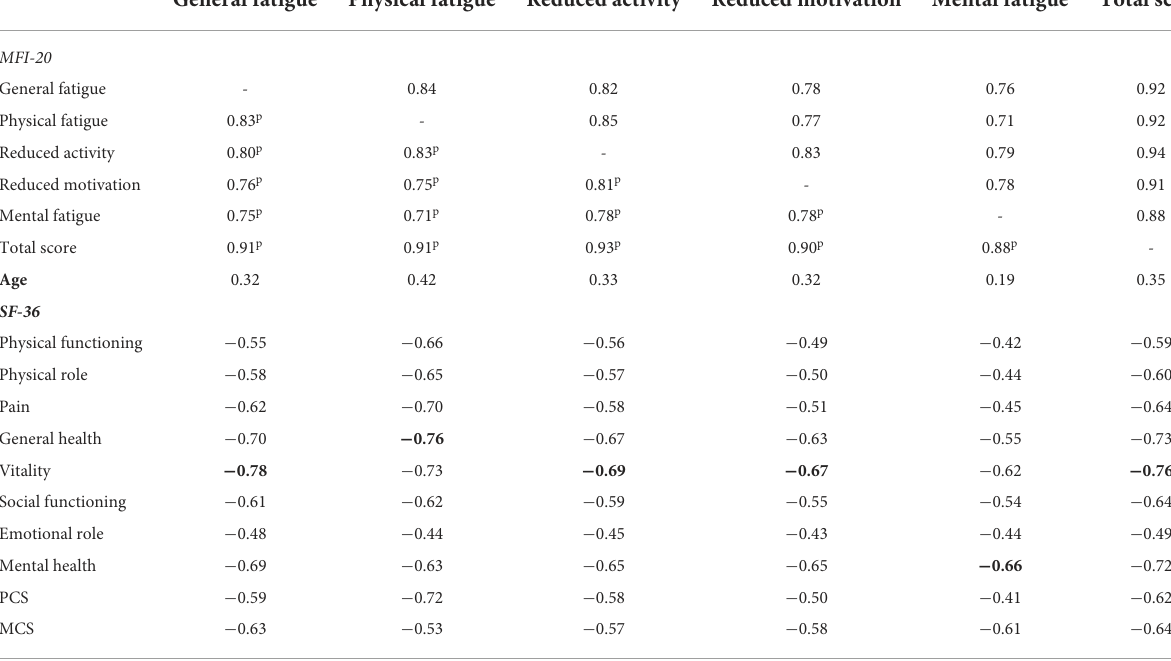
TABLE 3 Correlations between the MFI-20 scores, age, and SF-36 domains/composite scores. General fatigue Physical fatigue Reduced activity Reduced motivation Mental fatigue Total score